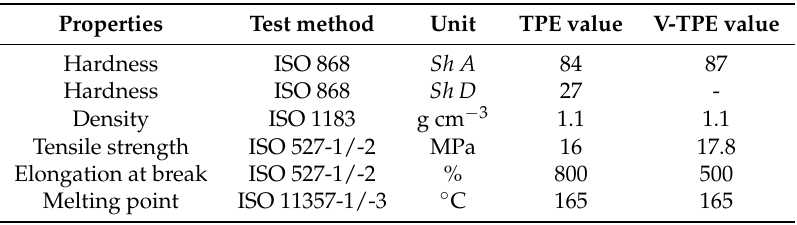
Table 1. TPE general